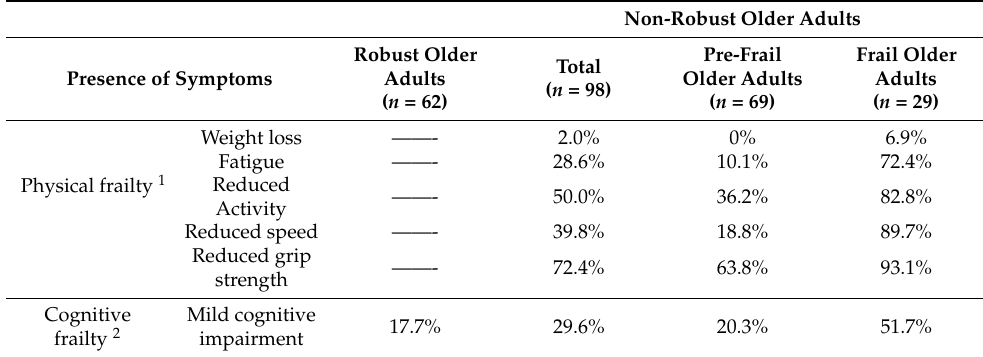
Table 2. Percentage of older adults with symptoms of cognitive and physical